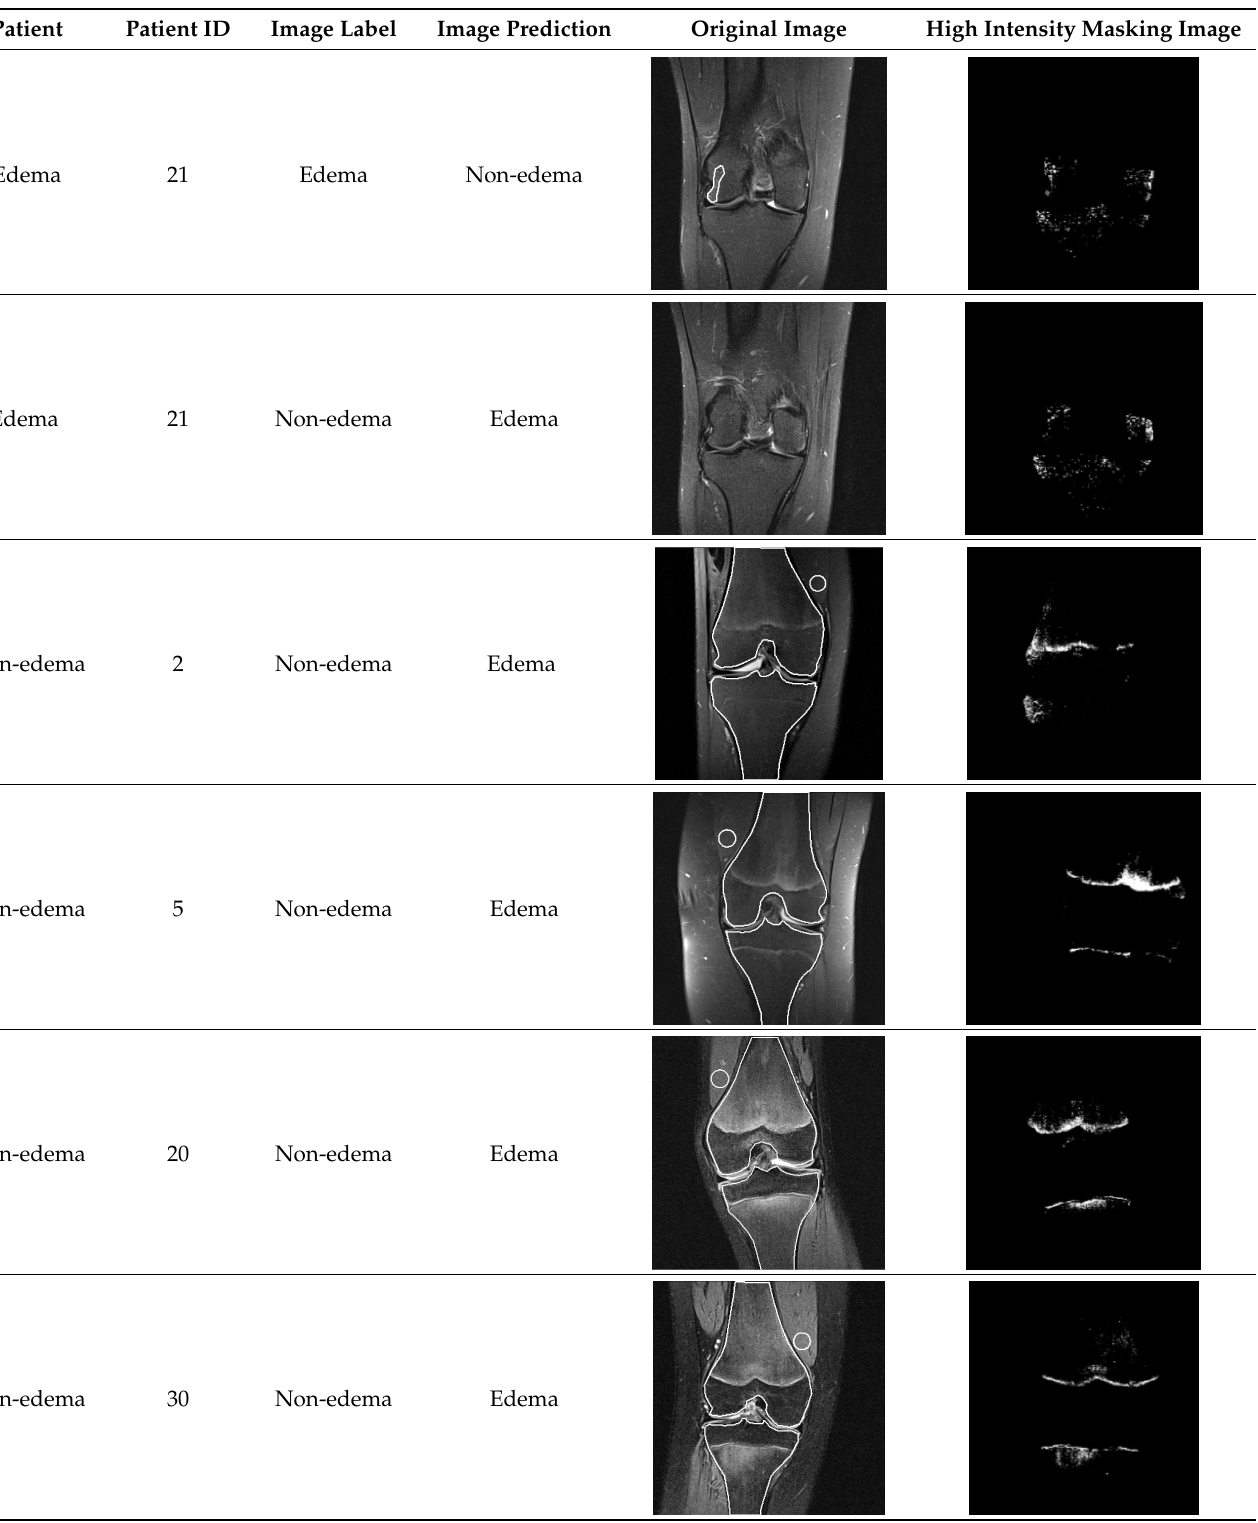
Table 6. Examples of misclassified slices by the best performing